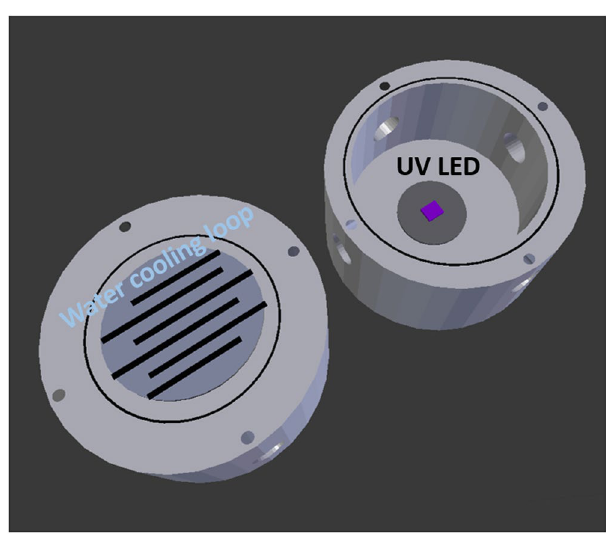
Figure 9. Schematic figure of the custom-made membrane test cell.